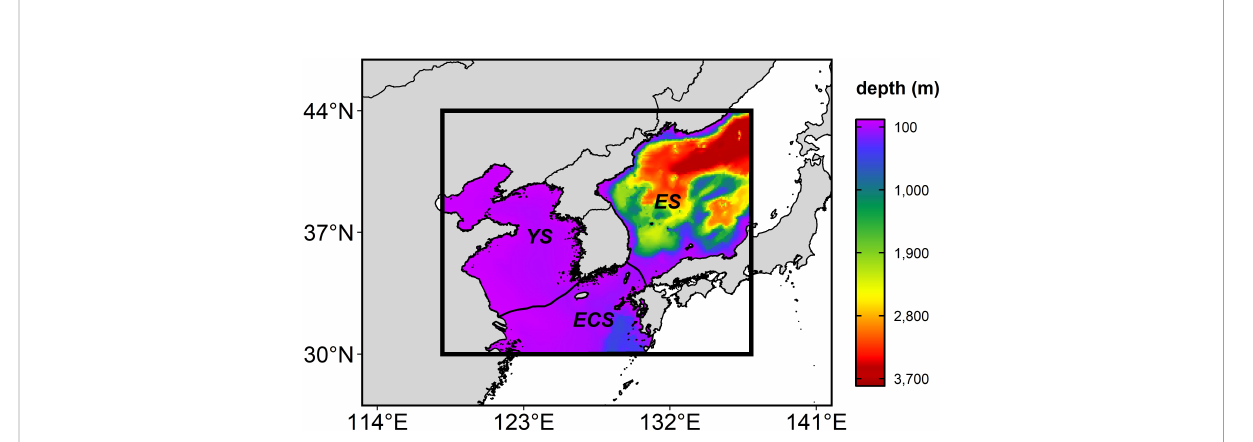
FIGURE 1 The study area (the thick box) (118-137°E and 33-44°N), including the East Sea (ES), the Yellow Sea (YS), and the East China Sea (ECS), overlaid with bathymetry (shade). The regional ocean boundaries are de fi ned by the Large Marine Ecosystems Hub